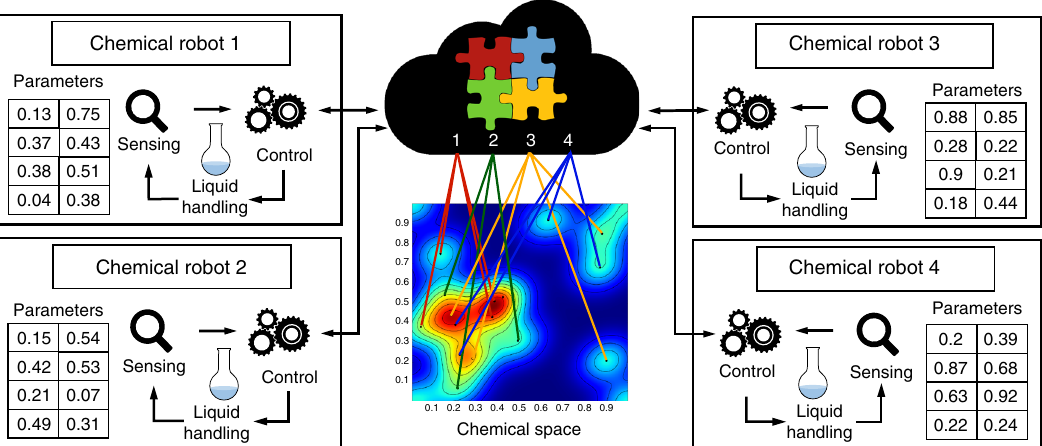
Fig. 1 Schematic describing the concept of real-time networked chemical robots. Here four physically separated units (ChemPUs) are connected to a cloud via the internet. They receive the reactions parameters from the cloud in order to explore a chemical space in an optimised way, when the reactions are done the analysis results are returned and shared trough the